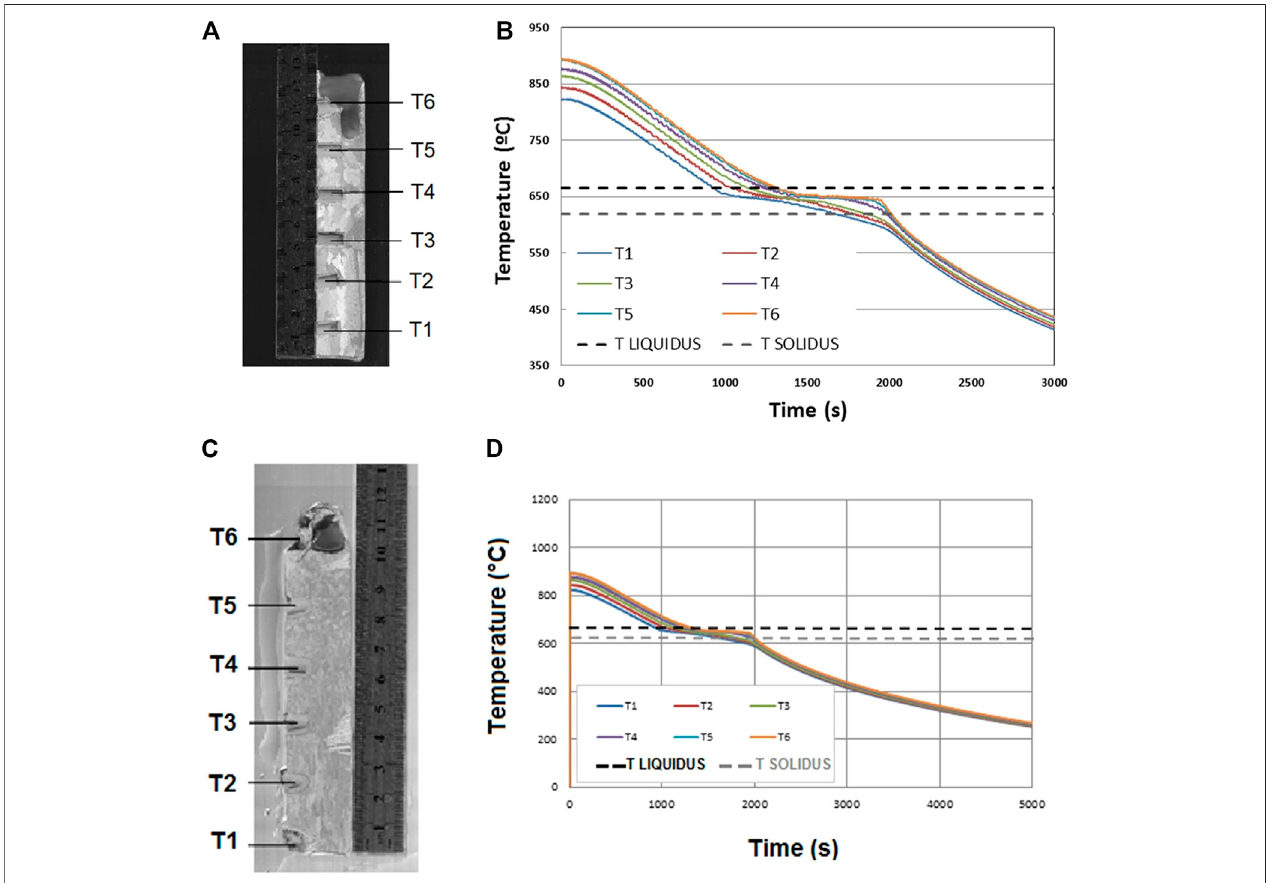
FIGURE3|(A) MacrostructureofAl-0.5wt.%Mgalloyindicatingthepositionofthethermocouplesduringtheexperiment. (B) CoolingcurvesofAl-0.5wt.%Mgalloy ineachpositionofthethermocouples. (C) MacrostructureofAl-2wt.%Mgalloyindicatingthepositionofthethermocouplesduringtheexperiment. (D) Coolingcurvesof Al-2. wt.%Mg alloy in each position of the